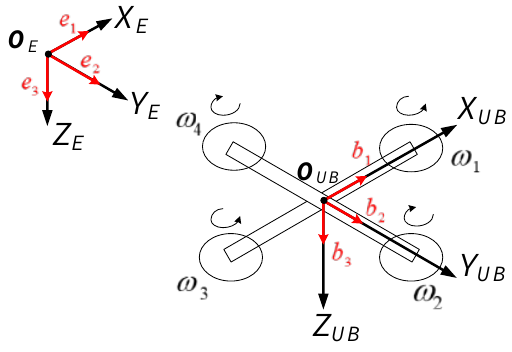
Figure 2. The world and body frames.